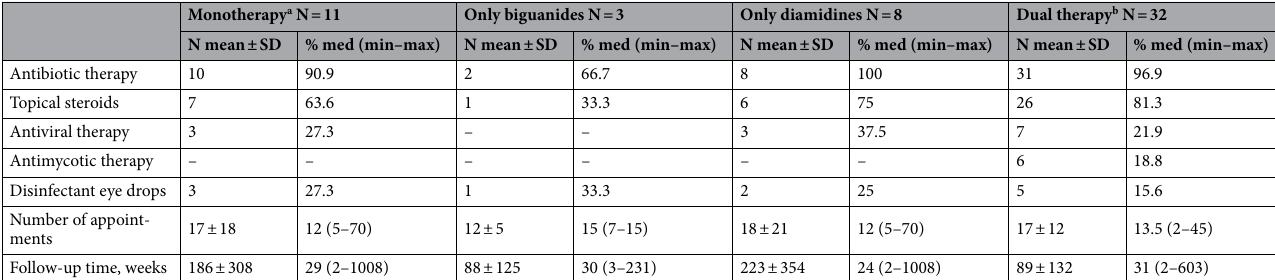
Table 2. Concomitant medications and follow-up times. a Defined as a monotherapy with either biguanides or diamidines. b Defined as the combination of biguanides and diamidines in the same eye during the course of therapy. max maximum, med median, min minimum, N absolute number, SD standard